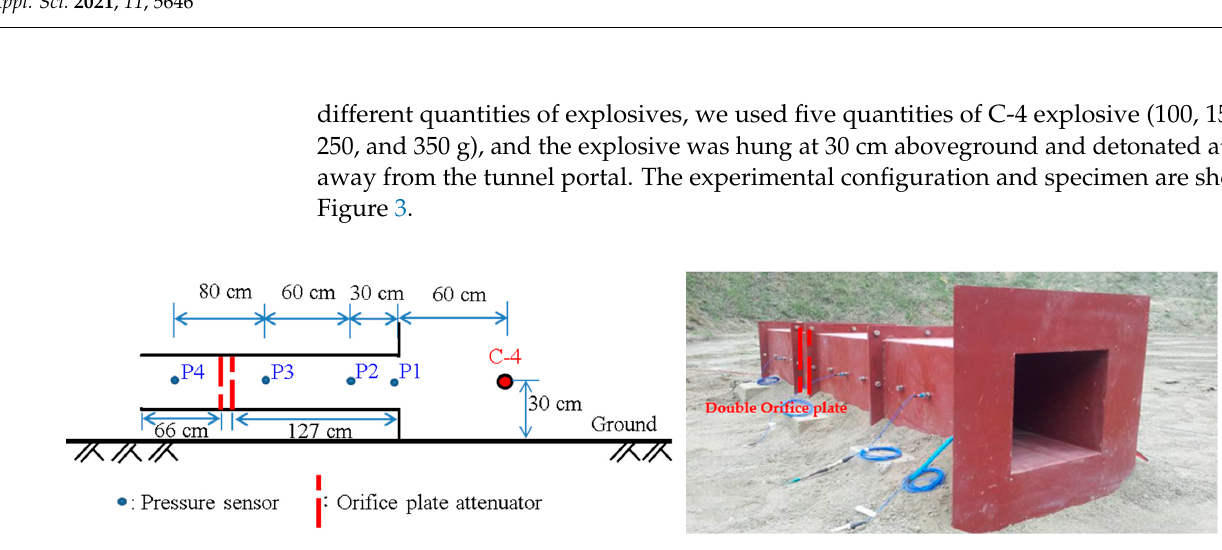
Figure 3. Experimental configuration and specimen of the linear tunnel with double-pressure relief orifice plate.